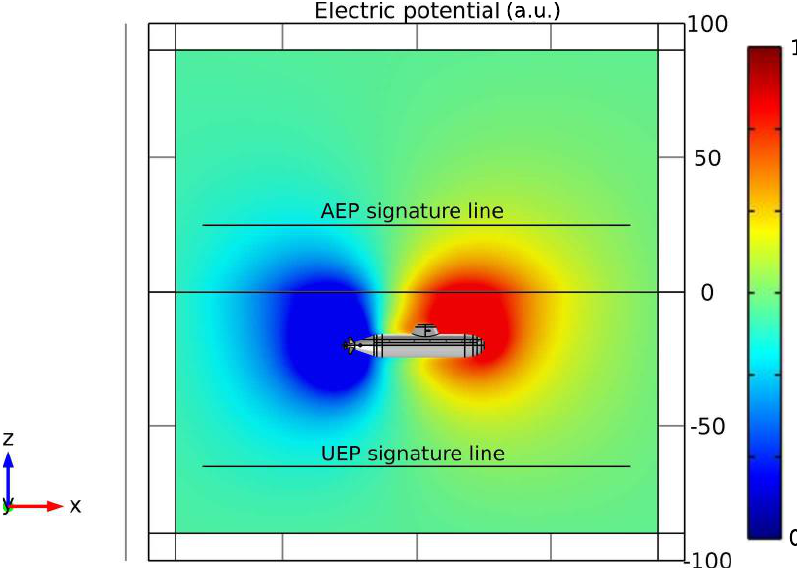
Figure 8. Numerically simulated potential distribution for a submarine model. The two black lines represent the evaluation location of the underwater electric potential (UEP) signature ( z u = −65 m, Figure 11) and the above-water electric potential (AEP) signature ( z a = +25 m, Figure 12).